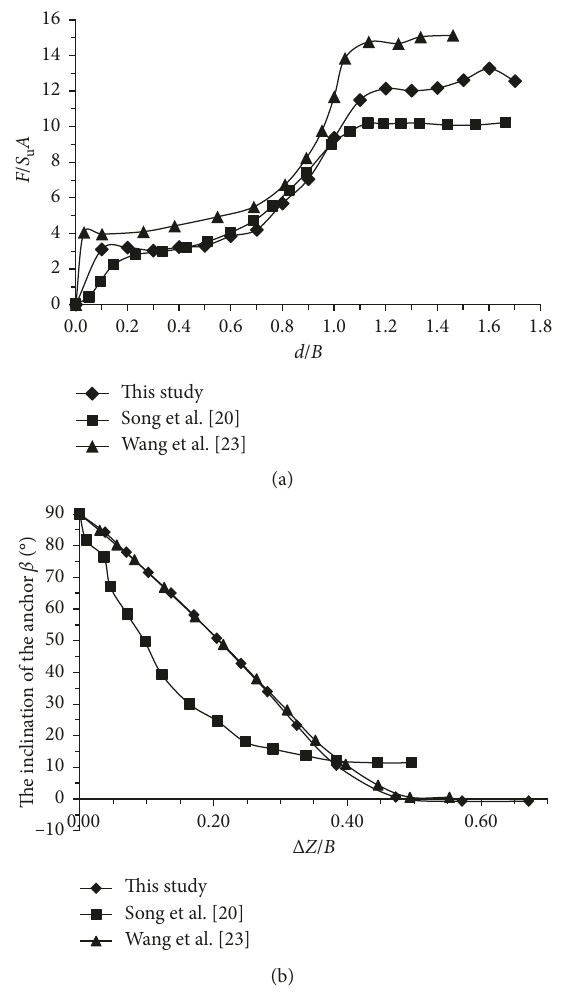
Figure 2: Comparison with test results by Song et al. [20] and with the numerical results by Wang et al. [23] for uniform soil: (a) normalized load-displacement relationship; (b) variations of plate inclinations with the normalized embedment